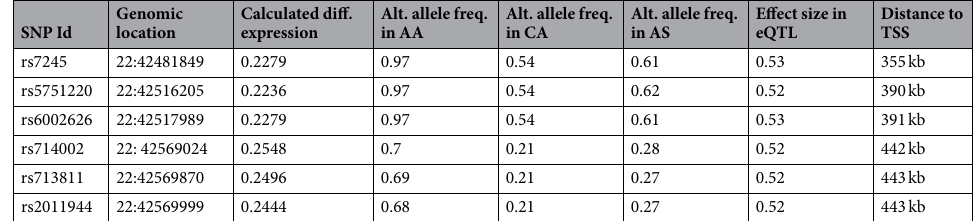
Table 2. SNPs that may be associated with the differential expression of CYP2D6 in breast cancer